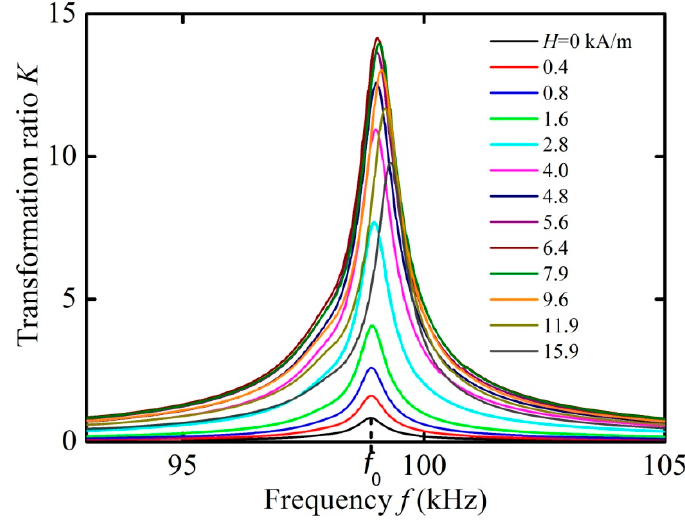
Figure 3. Dependences of the voltage transformation ratio K on the frequency f for different control fields H (0–15.9 kA/m) under open-circuit condition.